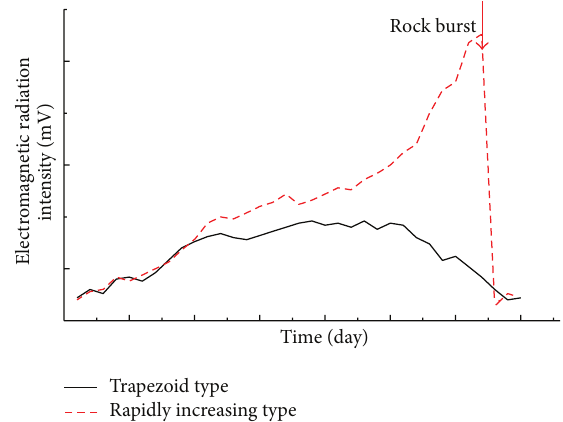
Figure 3: Patterns of the electromagnetic radiation intensity with the closing of the coal face to the fault.